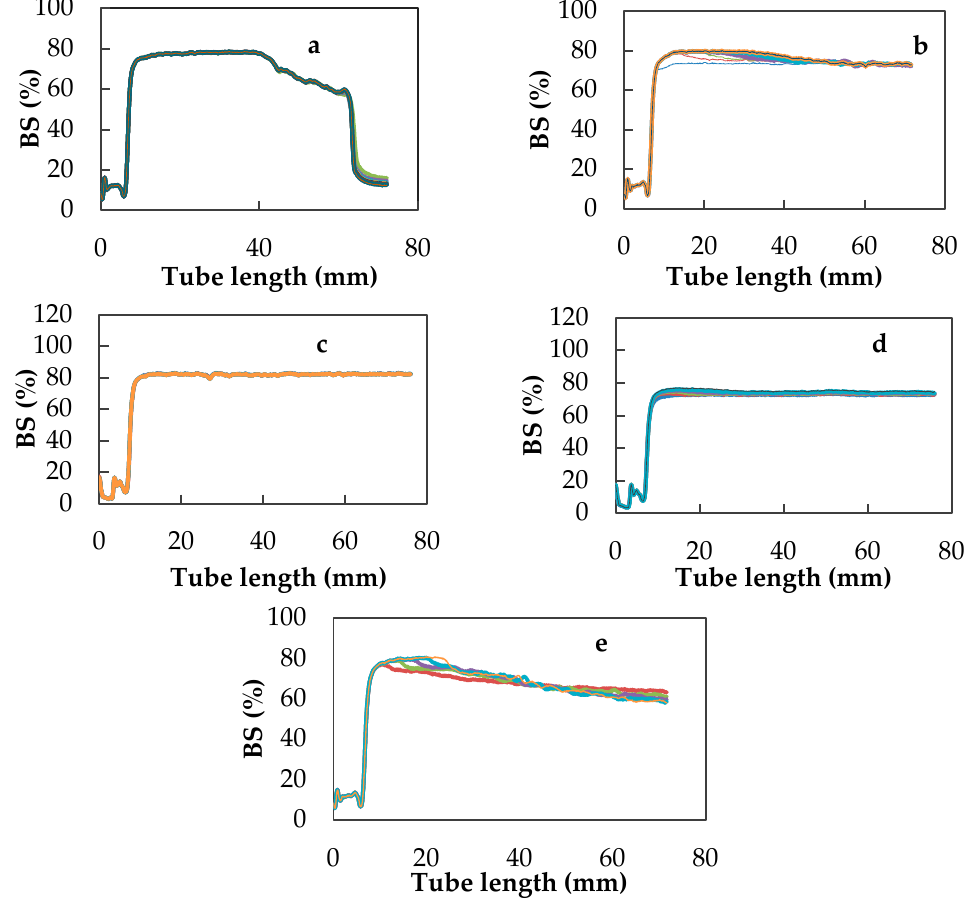
Figure 1. Changes in the backscattering (BS) profile (%) as a function of sample height with varying BGNS:BGN-SDF concentrations at ( a ) 5:0.65, ( b ) 10:1.3, ( c ) 15:1.95, ( d ) 15:0.65, and ( e ) 5:1.95.